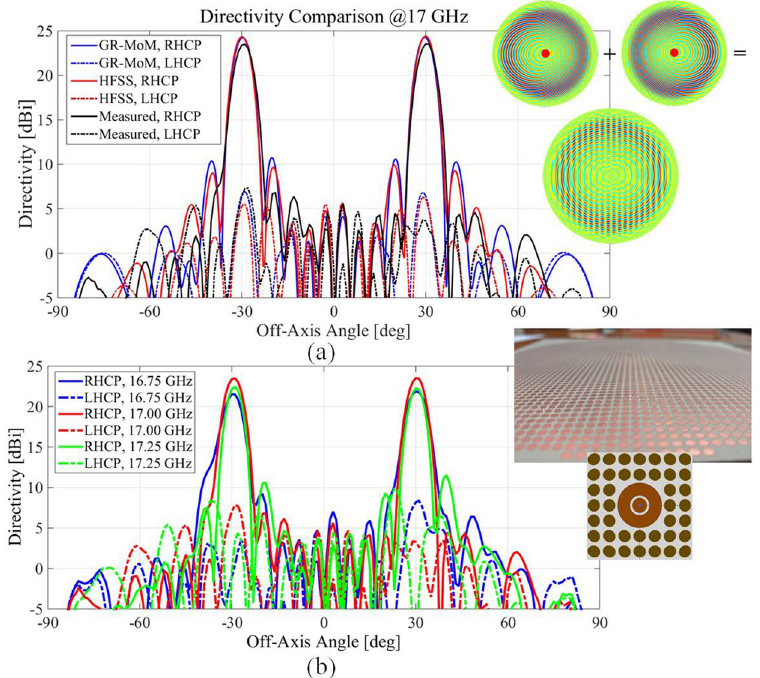
Figure 8. Multibeam MTS antenna radiation performances. ( a ) Simulated (blue line and red line for the IBC- MoM and full-wave results, respectively) and measured (black line) directivity pattern for the multibeam shared aperture MTS antenna at 17 GHz. The obtained beams point in the desired direction, with good cross polar discrimination and beam symmetry. ( b ) Measured directivity patterns at 16.75 GHz, 17 GHz and 17.25